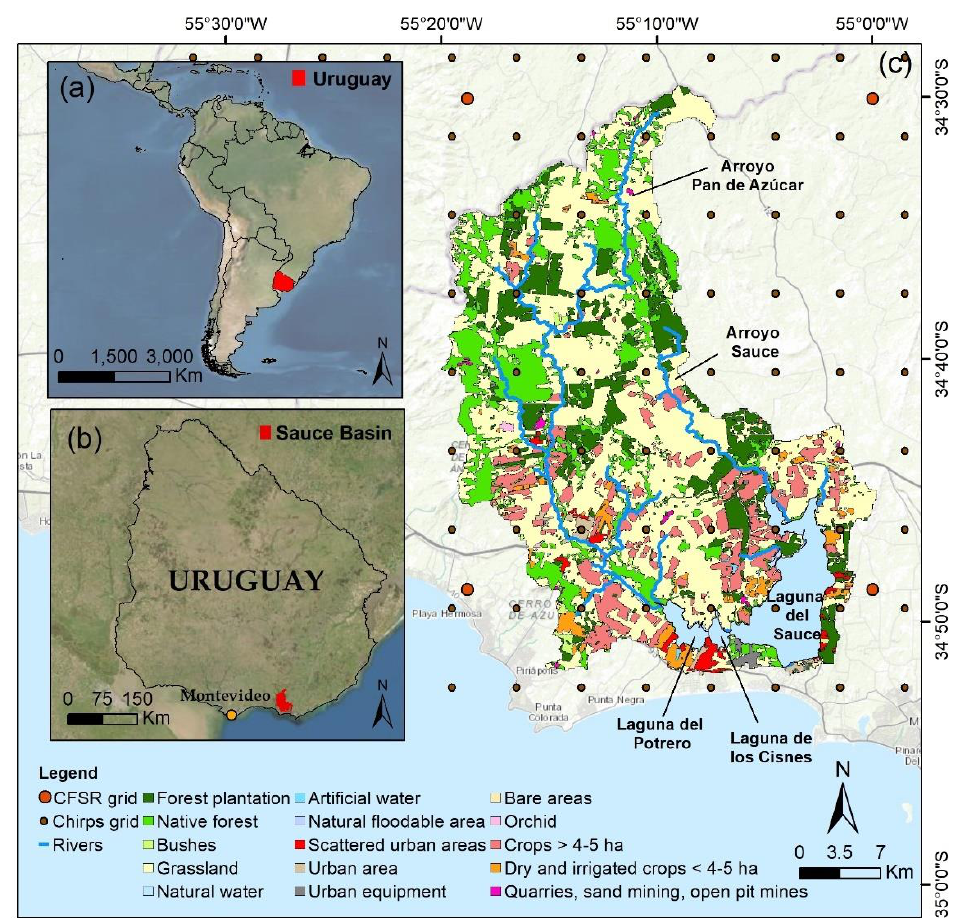
Figure 1. Location of the Laguna del Sauce basin in ( a ) South America, ( b ) Uruguay and ( c ) land uses in the catchment. Subsystems: Laguna del Sauce, Laguna de los Cisnes and Laguna del Potrero. Tributaries: Pan de Azúcar and Sauce river. Land uses for 2015 [35].